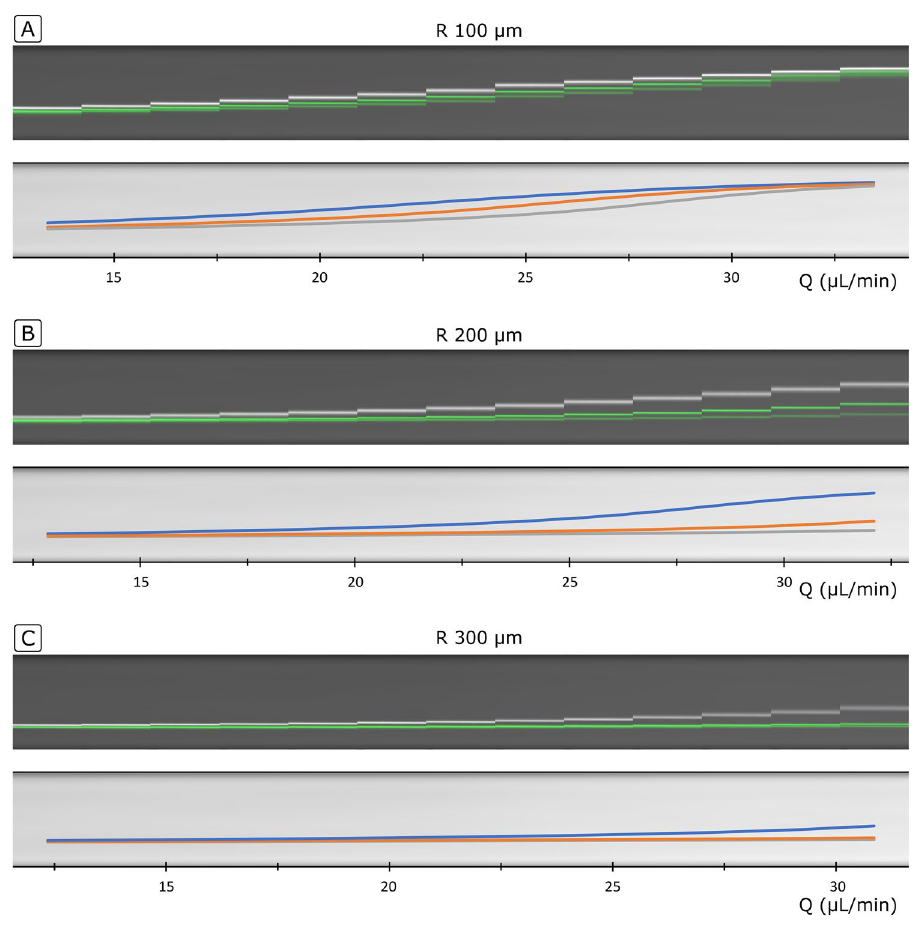
Figure 8. Performance of the separation section (half loop, 6.15 × 14.5 µm ( W × H )) with 0.79, 0.92 and 1.0 µm particles. Experimental positions observed at the 80 µm wide expansion of the channels (top) and prediction by the model (bottom). ( A ) R 100 µm, ( B ) R 200 µm, ( C ) R 300